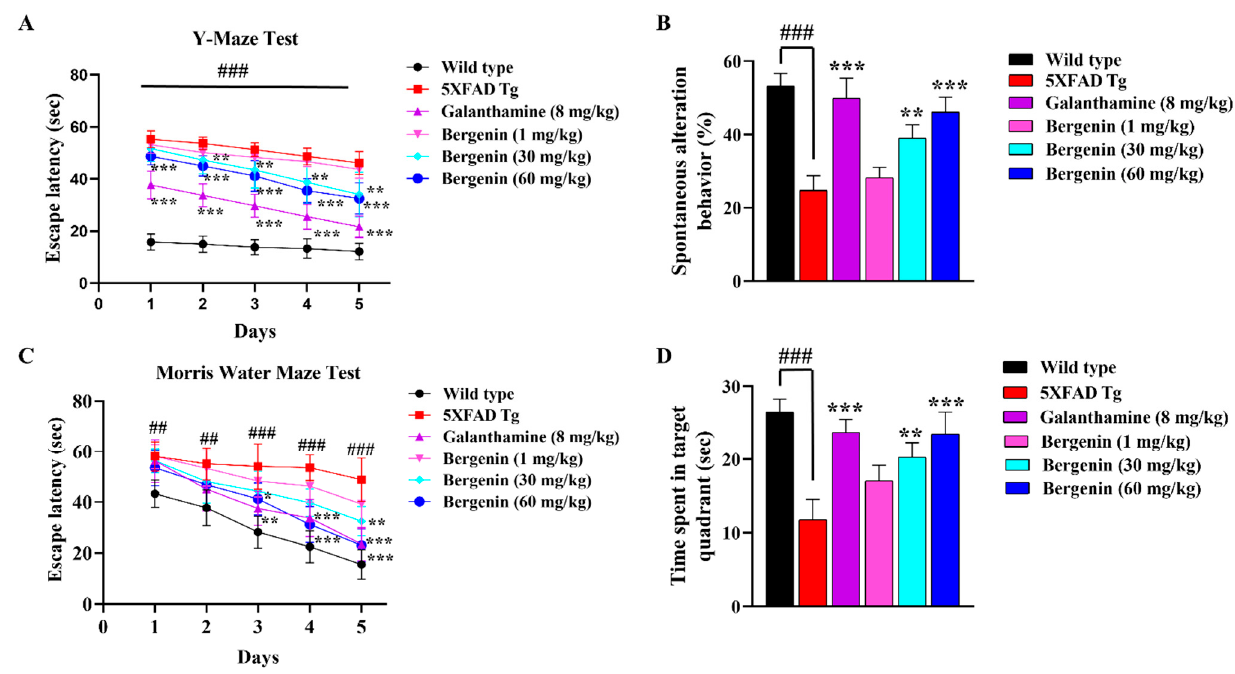
Figure 2. Bergenin attenuated spatial memory deficit in 5xFAD Tg mice. In the Y-maze test ( A ) Escape latency from day 1 to 5 and ( B ) % Spontaneous alteration behavior (SAB) on day 14th was evaluated in all the experimental groups. In the Morris water maze (MWM) test ( C ) Escape latency from day 1 to 5 and ( D ) Time spent in the target quadrant (probe test) on day 14th was evaluated in all the experimental groups. Results were expressed as mean ± S.D ( n = 10). * p < 0.05, ** p < 0.01 and *** p < 0.001 versus the transgenic mice group, ## p < 0.01 and ### p < 0.001 versus the control